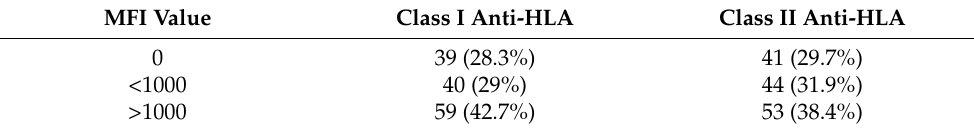
Table 2. The size of the study group depending on the MFI value in individual anti-HLA classes.